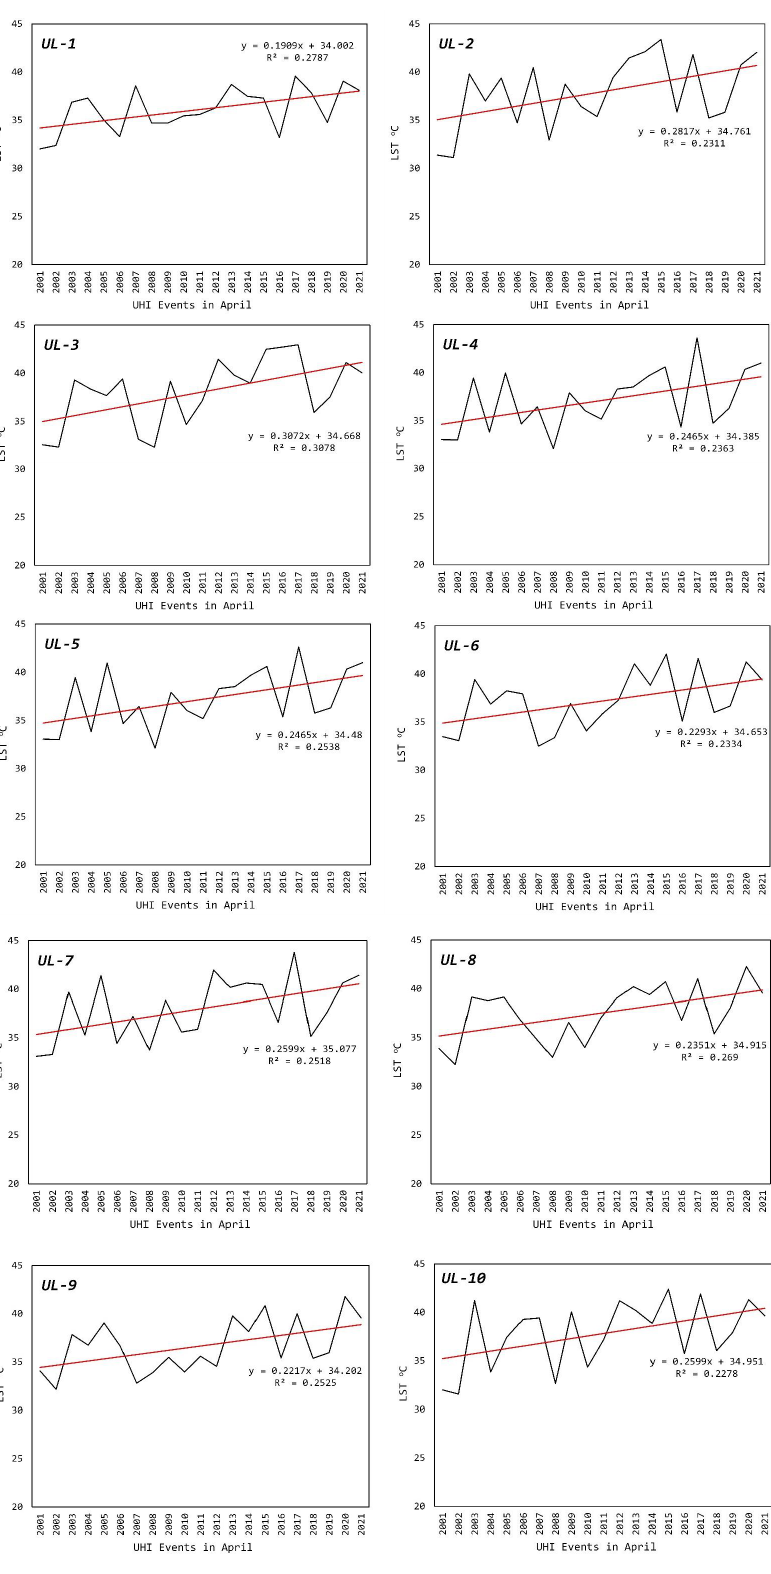
Figure 8. Trend analysis of the UHI events of the selected urban locations ( UL ) in the month of April from 2001 to 2021. UL1 Hegganahalli, UL2 Kurubarahalli, UL3 Malleswaram, UL4 Banashankari, UL5 Electronic City, UL6 Jayanagar, UL7 Indiranagar, UL8 Koramangala, UL9 Hebbal, and UL10 Gandhi